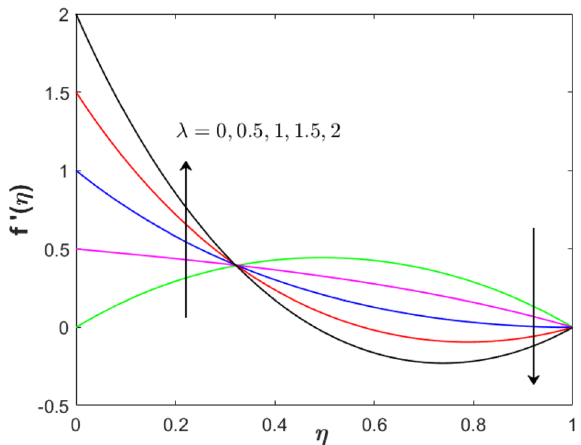
Figure 6. Effect of stretching parameter on f ′ (η) when S = 0.2 , Sq = M = 1 and φ 1 = φ 2 = 0.01 .